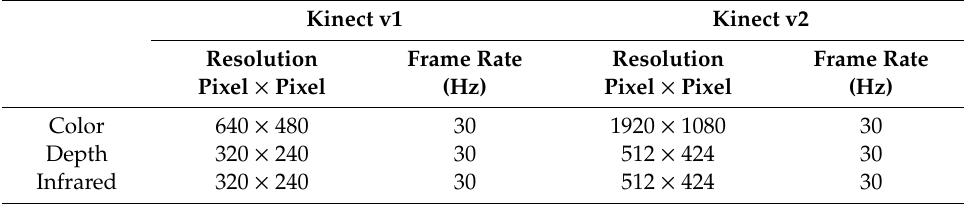
Table 1. Specification for resolution and frame rate of pictures captured by Kinect v1 and Kinect